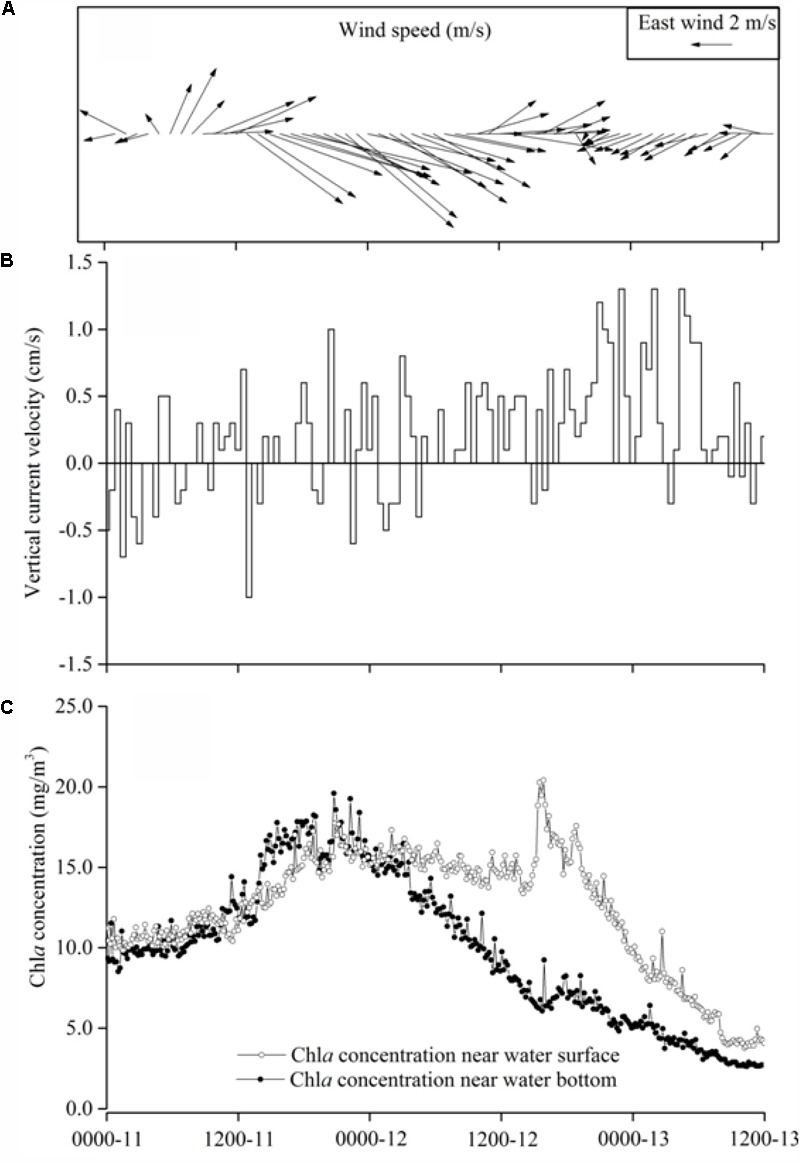
Observations during Typhoon Morakot in August 12–13, 2009 in Lake Taihu. (A) The wind speed and wind direction. (B) Speed of suspended particulate matter (cyanobacterial colonies) moving up and down recorded by ADCP. (C) Chlorophyll-a concentration at the surface layer and the bottom layer.